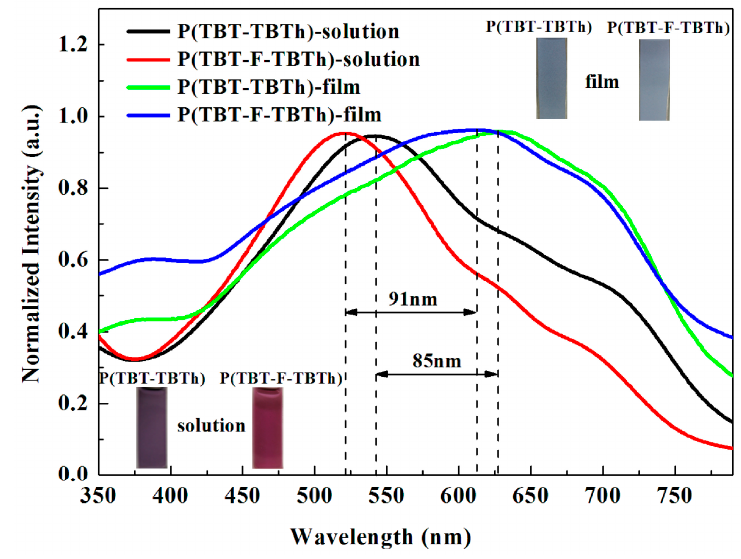
Figure 5. UV-vis spectra of the polymers in chloroform saturated solution and in thin film.